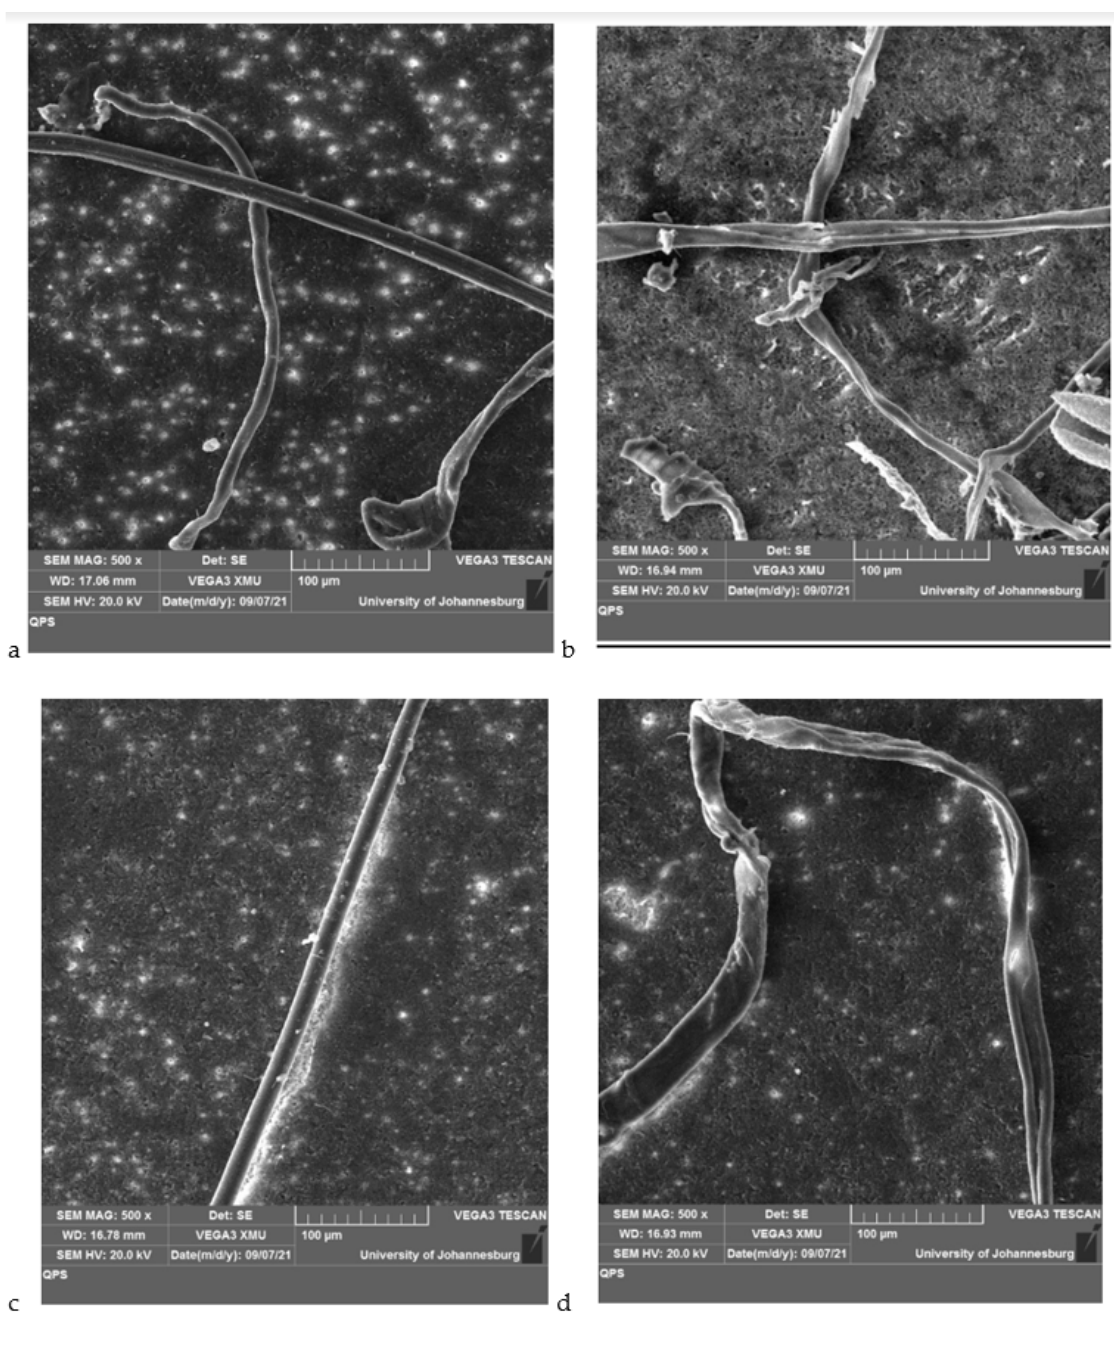
Figure 5. SEM images of microplastics filtered through PVDF/CNOs membranes from ( a ) tap water, ( b ) lake water, ( c ) influent, and ( d ) effluent. ( b ) lake water, ( c ) influent, and ( d )